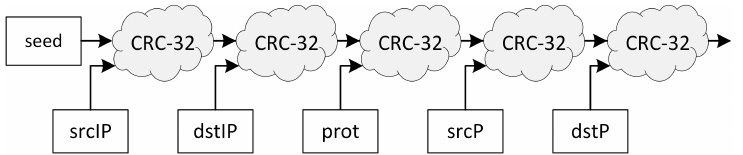
Figure 2. Illustration of Vermont hashing function.